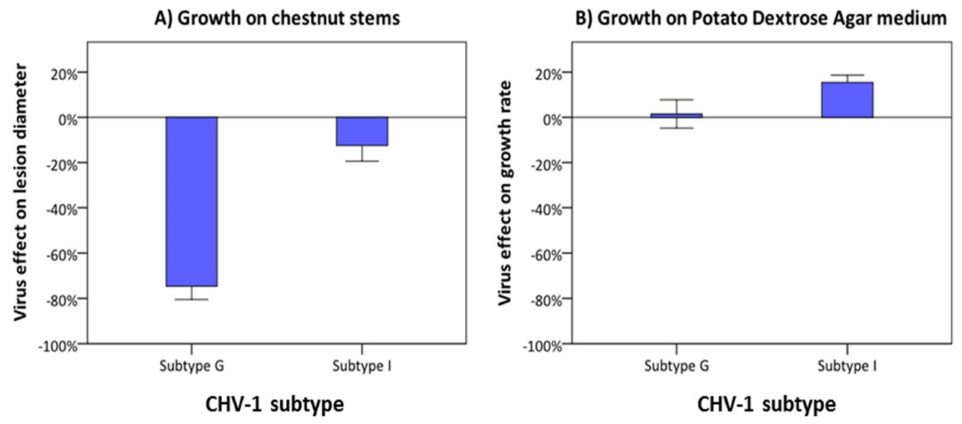
Figure 5. Effect of the Georgian (G) and the Italian (I) CHV-1 subtypes on the growth of C. parasitica isolates from the European gene pool on dormant chestnut stems ( A ) and on PDA ( B ). The virus effect was quantified as the difference in performance between the hypovirus-infected and its isogenic hypovirus-free isolate as percentage of the performance of the hypovirus-free isolate. Error bars represent the standard errors. Values with different letters differ significantly ( p <